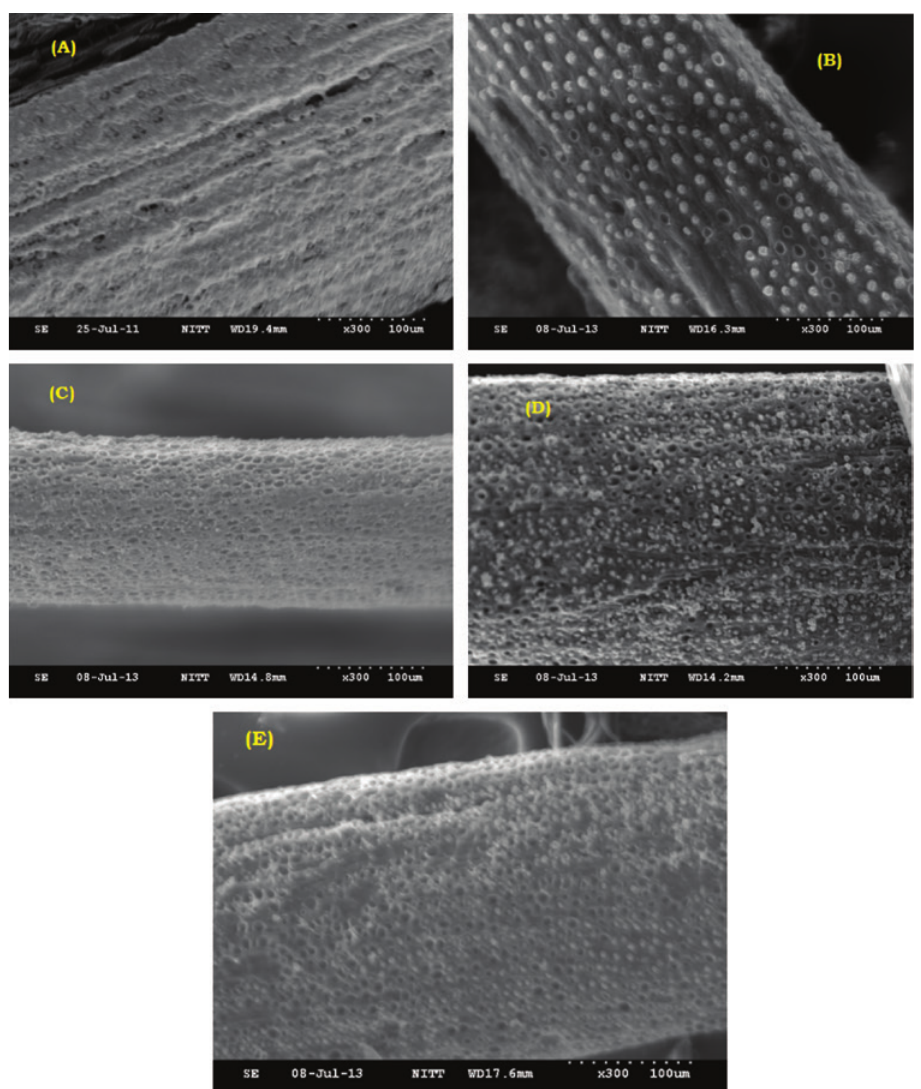
Figure 8: Scanning Electron Microscope (SEM) images of areca fibers: (A) untreated; (B) alkali treated; (C) permanganate treated; (D) benzoyl chloride treated and (E) acrylic acid